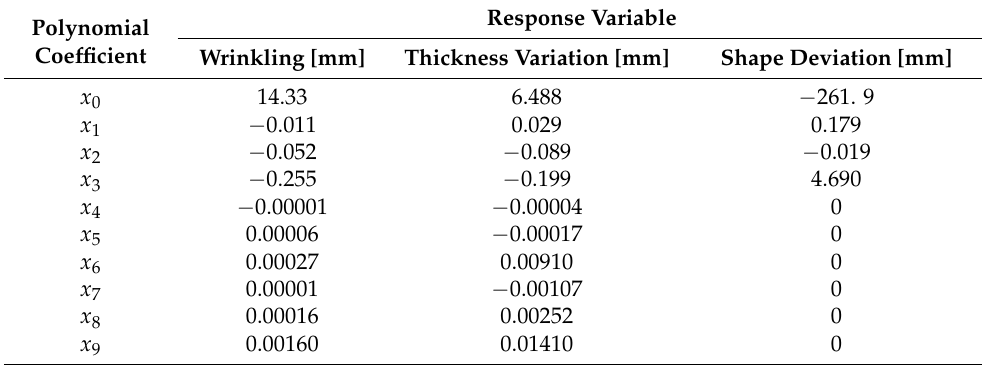
Table 4. Polynomial coefficients for the response variable equation.